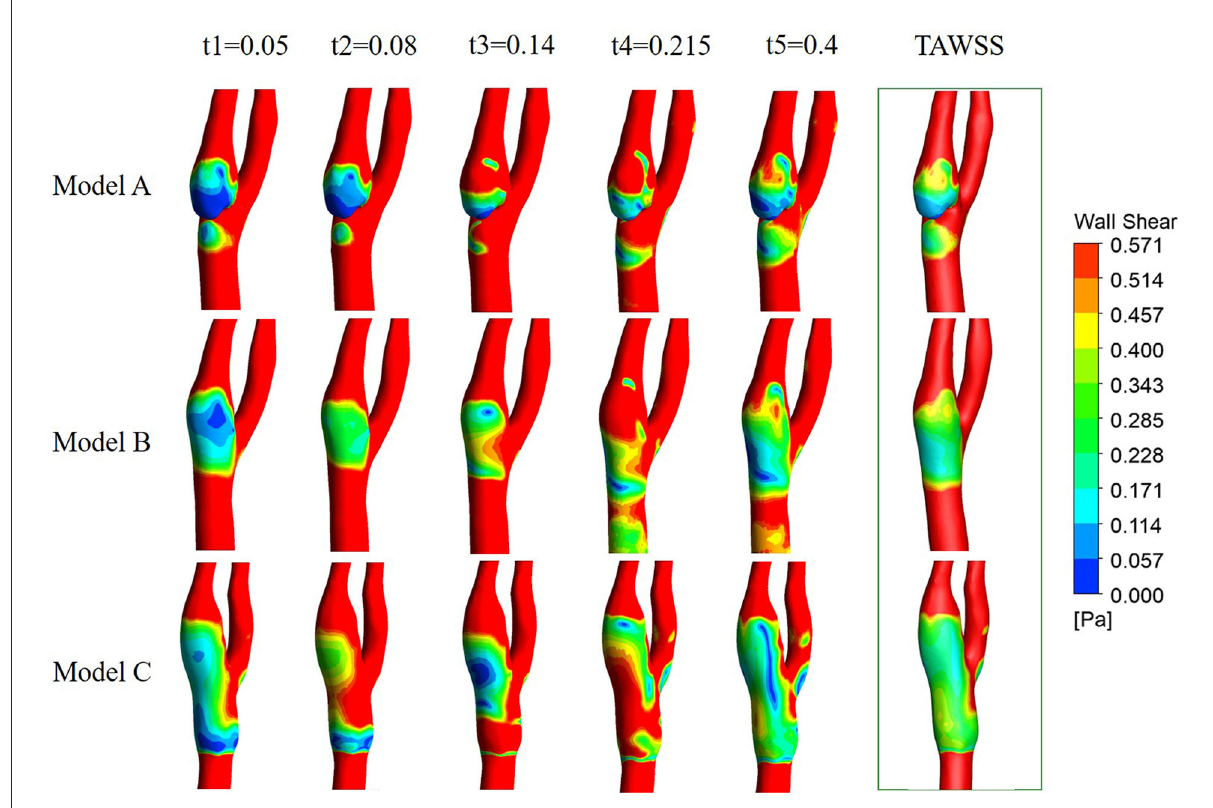
FIGURE7 Contours of WSS at the five time points and the contours of